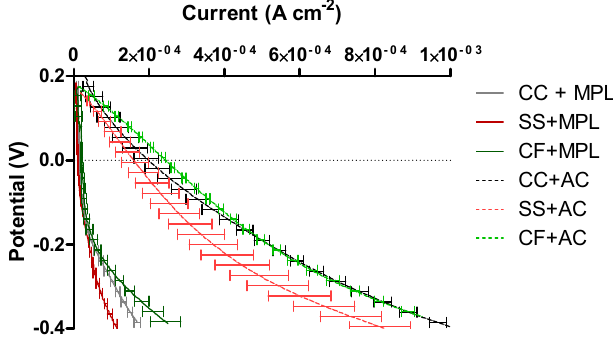
Figure 5. Linear sweep voltammetry of the different cathode electrodes tested at pH